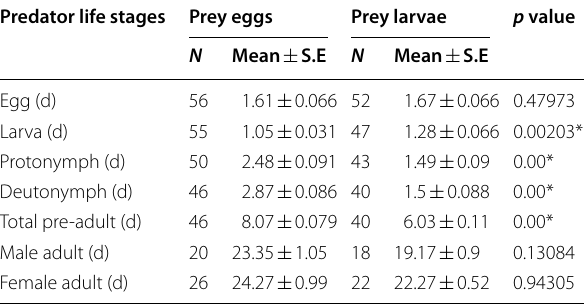
Standard errors were estimated by using 100,000 bootstraps. *Means followed by marked p values in each row are significantly different between two treatments using the paired bootstrap test at the 5% significance